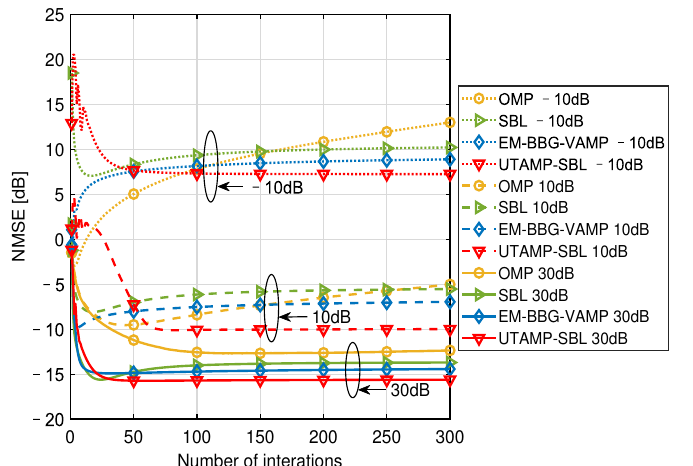
Figure 5. The NMSE versus the number of iterations at different SNRs with 25.00% pilot